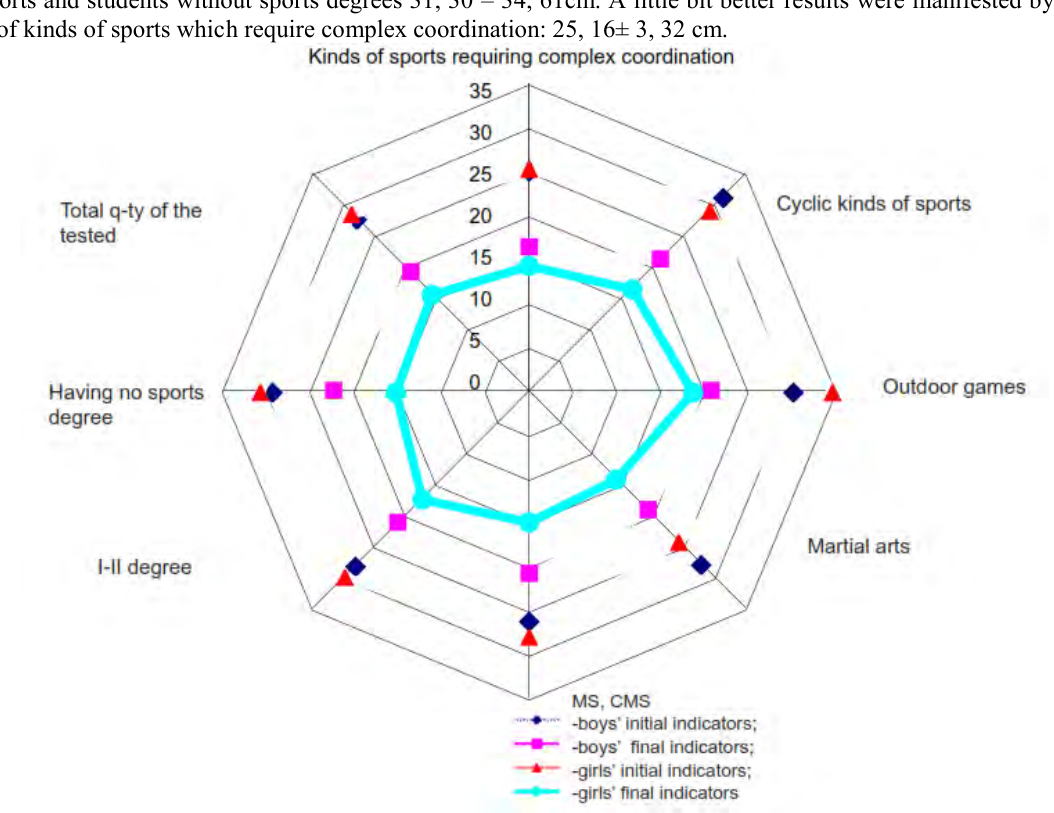
Fig. 12. Indicators, which characterize coordination abilities to static dynamic balance of NU PESU first year